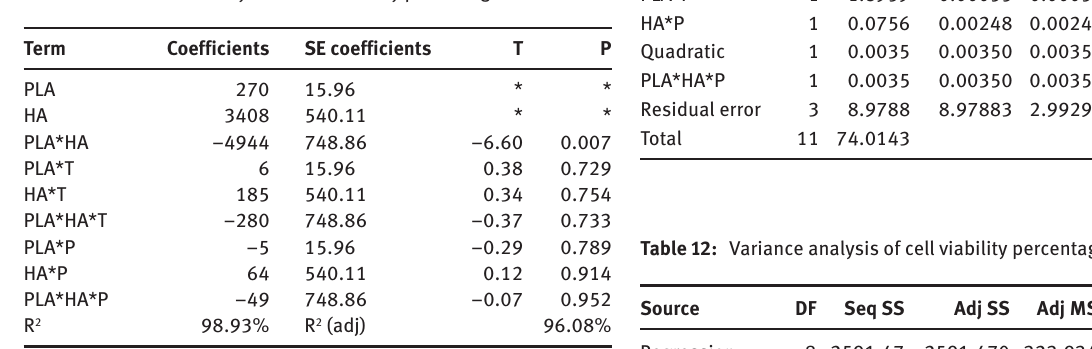
Table 9: Coefficient analysis of cell viability percentage.